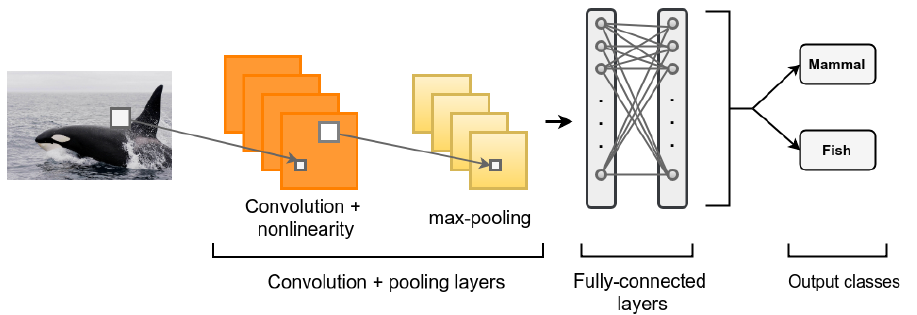
Figure 1. Example of a CNN for image classification.